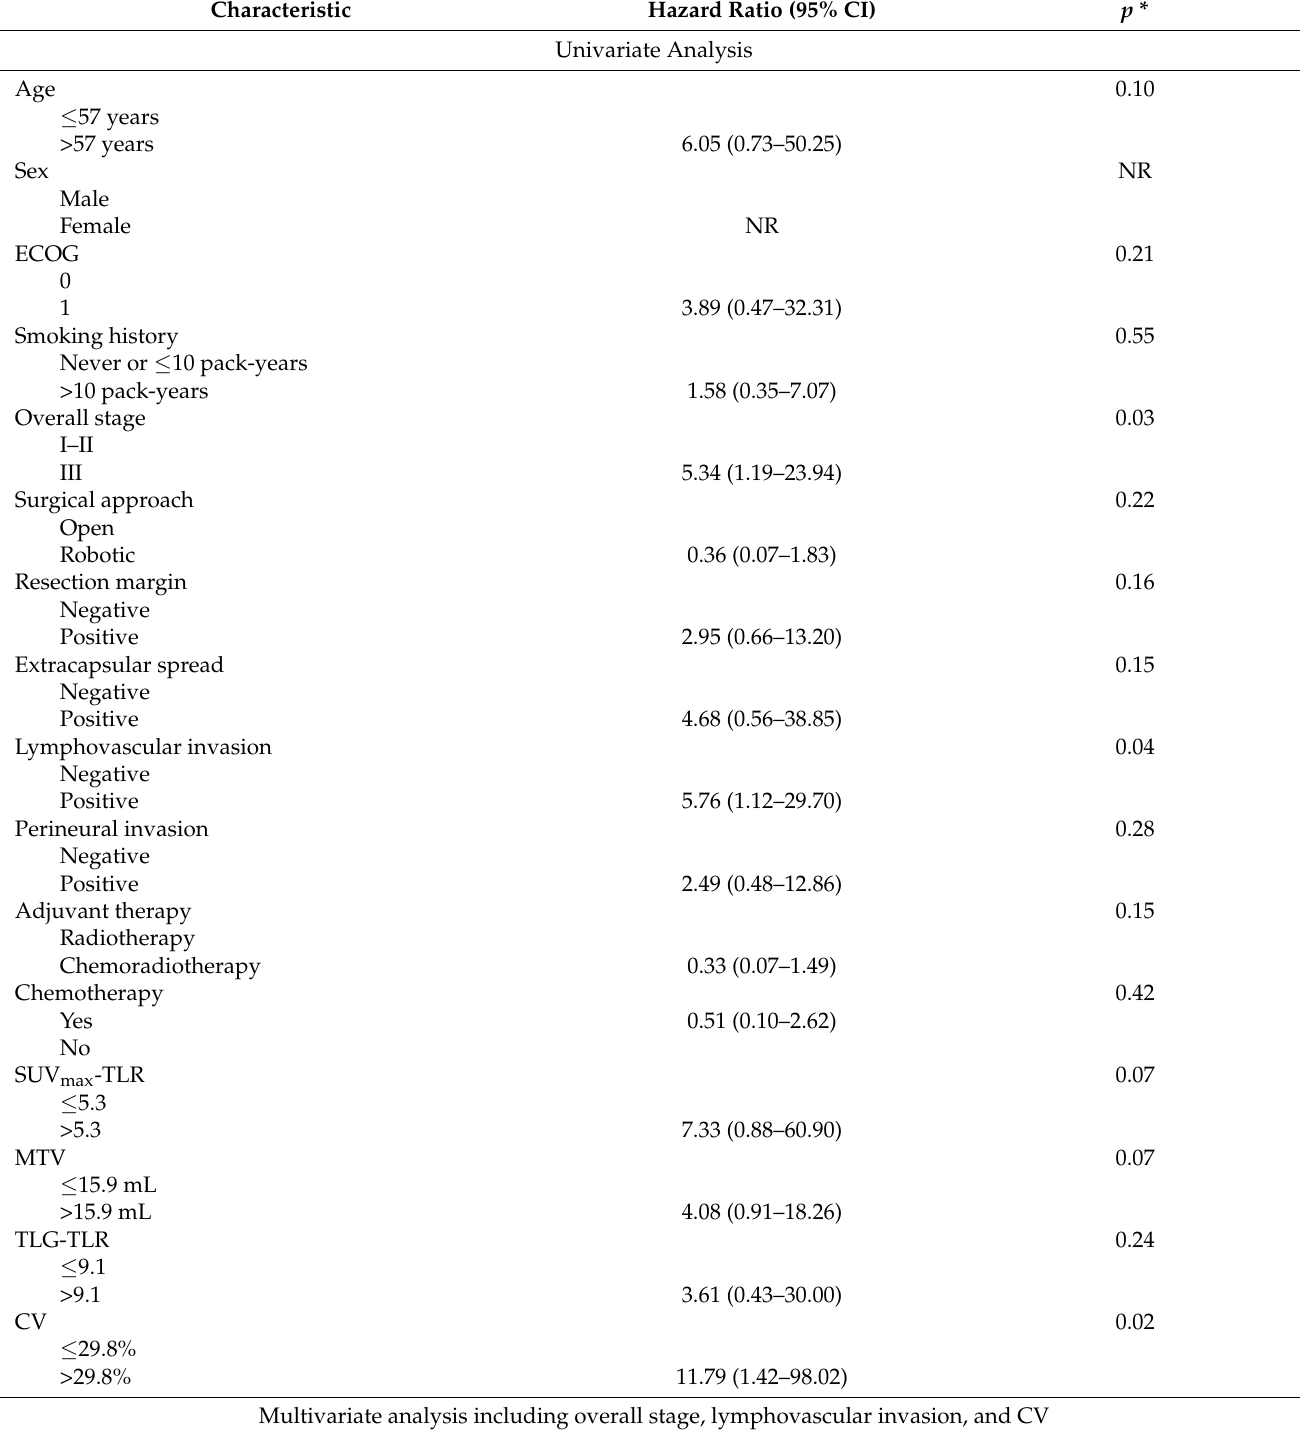
Table 6. Univariate and multivariate analyses for overall survival for patients who received surgery as the primary treatment.